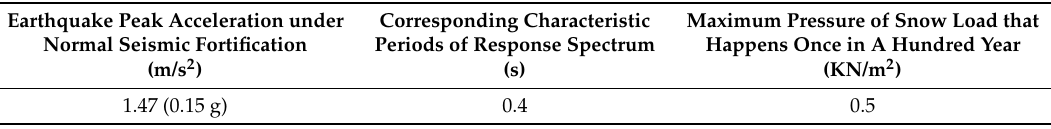
Table 1. Related technical parameters of location of Limestone Hall.